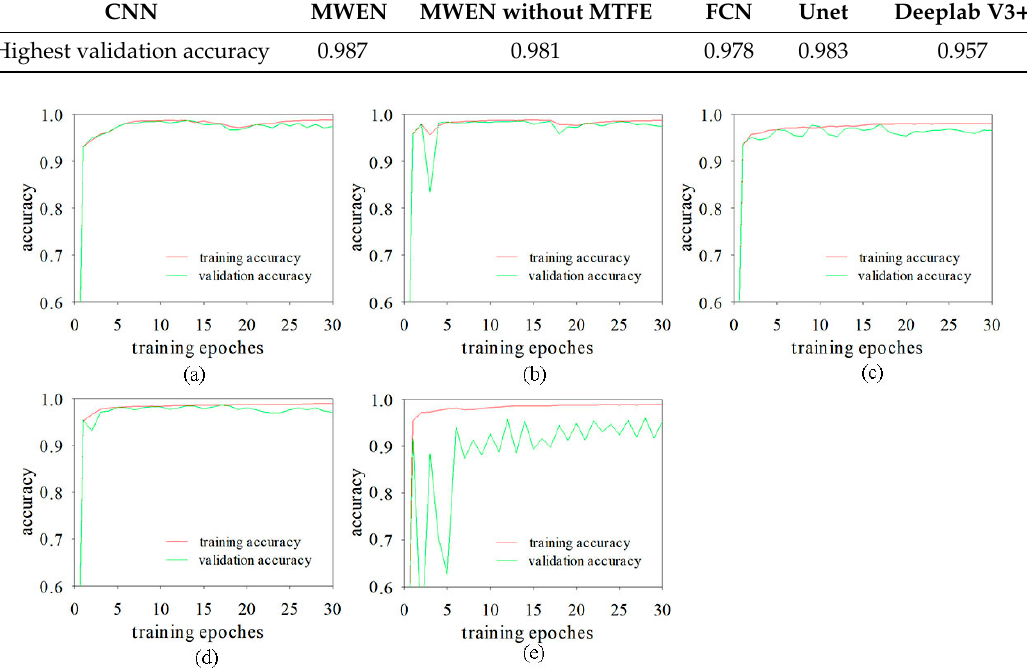
Figure 7. The training and validation accuracy curves of the convolutional neural networks (CNN) models. ( a ), ( b ), ( c ), ( d ), and ( e ) represent training and validation accuracy curves of the MWEN, MWEN “without multi-scale feature extractor (MTFE)”, fully convolutional network (FCN), Unet, and Deeplab V3 + , respectively. Table 4. The e ffi ciency comparison of the various Table 3. The highest validation accuracy of CNN models in training process.